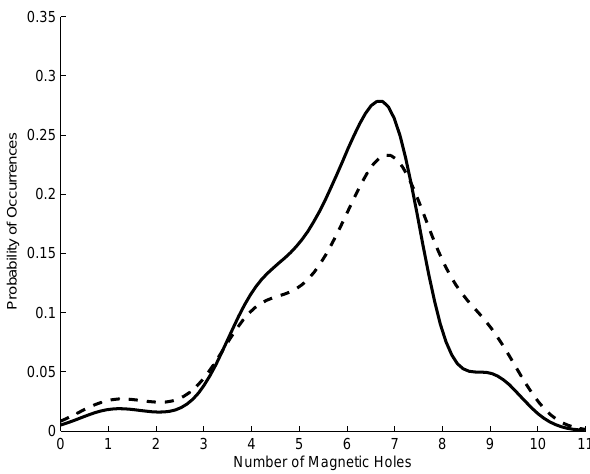
Fig. 3. VEX (dashed line) and Cluster (solid line) probability dis- tribution functions of the occurrence